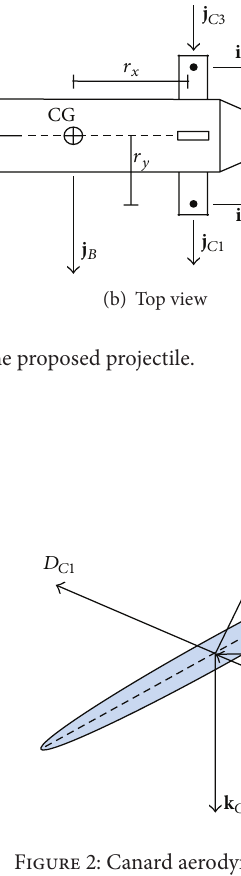
Figure 2: Canard aerodynamic model force